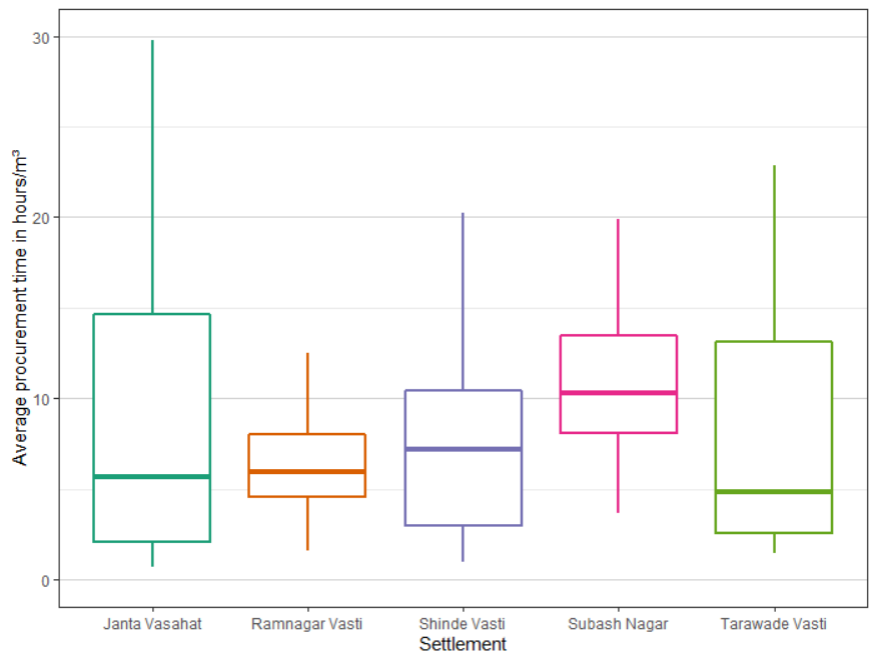
Figure 3. Distribution of time expenditure per m³ of water in each settlement (Data source: [41] January data). The distribution is more spread out in settlements with strong differences in flow rates (Janta Vasahat & Tarawade Vasti), with households in disadvantageous positions impacted by low flow rates. In Ramnagar, the overall procurement time per unit is more equitable, likely due to an established system of time slots at the public tap.